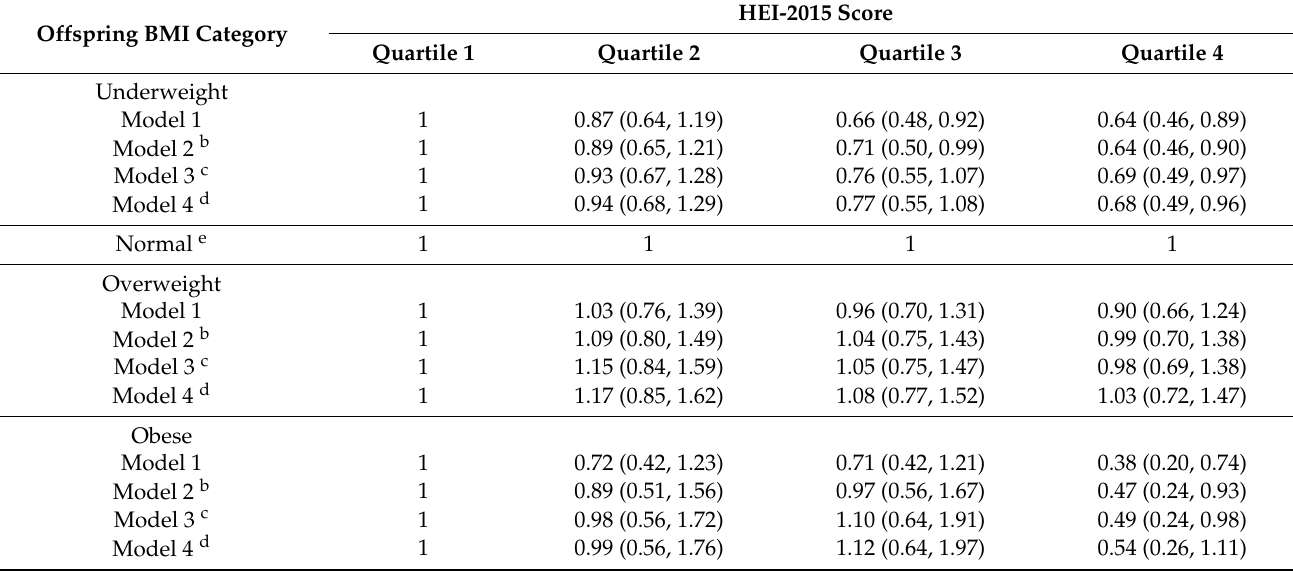
Table 3. Associations between offspring BMI category and pre-pregnancy HEI-2015 score ( n = 3391 from 1936 mothers) a . Offspring BMI Category